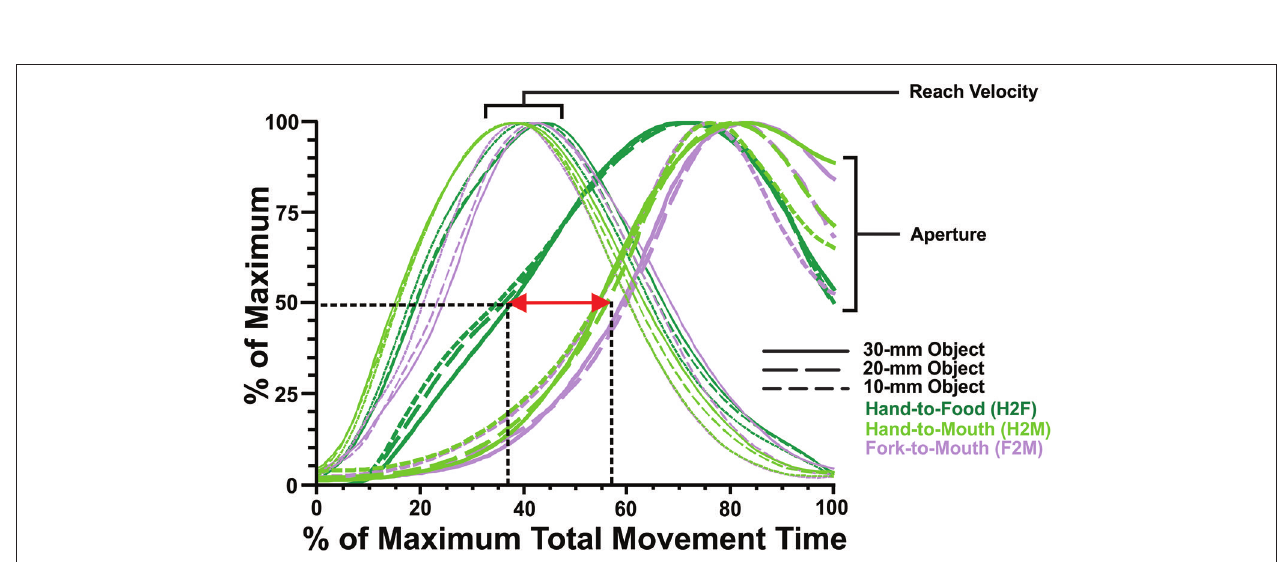
FIGURE 4 | Transport and grip component coordination. To illustrate component coordination, the grip and transport measures for the H2F, H2M and F2M movements have been resampled to a duration of 100 time points ( x -axis) and replotted as a percentage of maximal values on the y -axis. Reach velocity profiles are quite similar across testing conditions (H2F, H2M and F2M), reaching the peak 40–50% of the way through the movement; whereas aperture measures differ depending on reach direction (toward the food or toward the mouth). The aperture opens earlier for hand grasping than mouth biting, both when the aperture has reached 50% of its maximum ( ∼ 37% vs. ∼ 57% of movement time, respectively), and at its peak ( ∼ 70% vs. ∼ 80% of movement time, respectively).